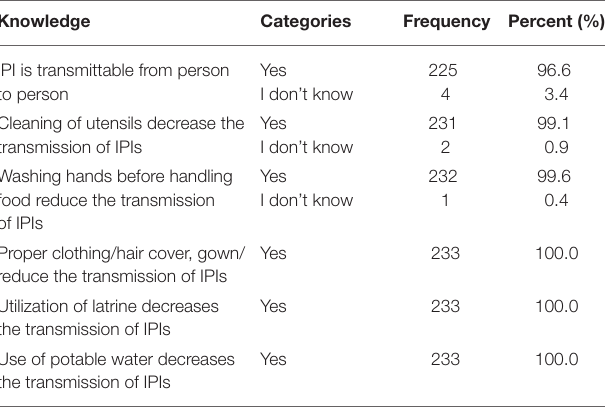
TABLE 4 | Prevalence of IPIs identified from food handlers worked in the students’ caterings of WSU, Wolaita Sodo, South Ethiopia from January 10 to February 10,